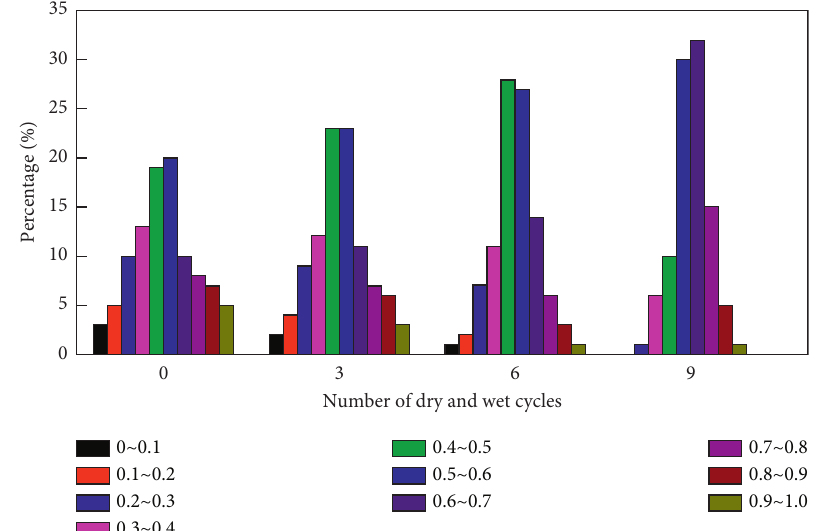
Figure 22: Abundance percentage distribution of soil particles under different drying-wetting